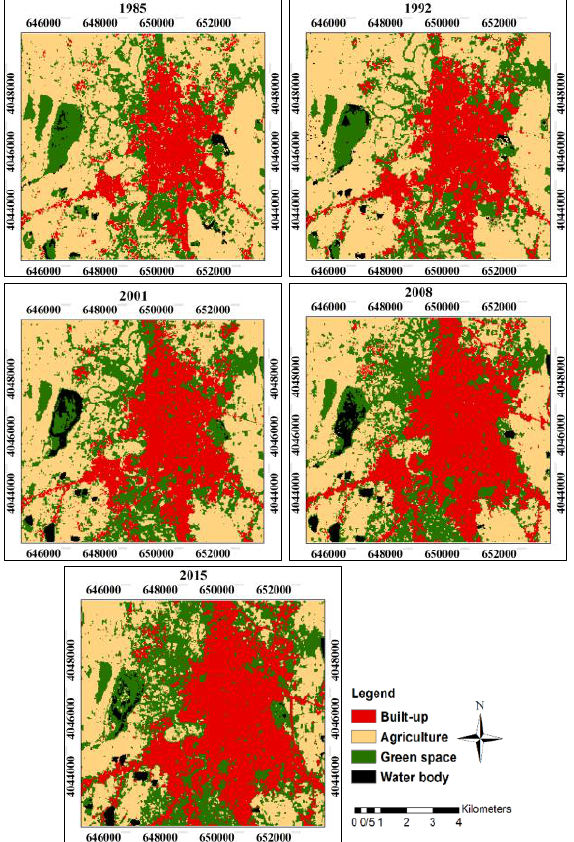
Figure 2. Results of the land use classification: 1985; 1992; 2001; 2015. Table 4. Areas of the Land use classes in the period of